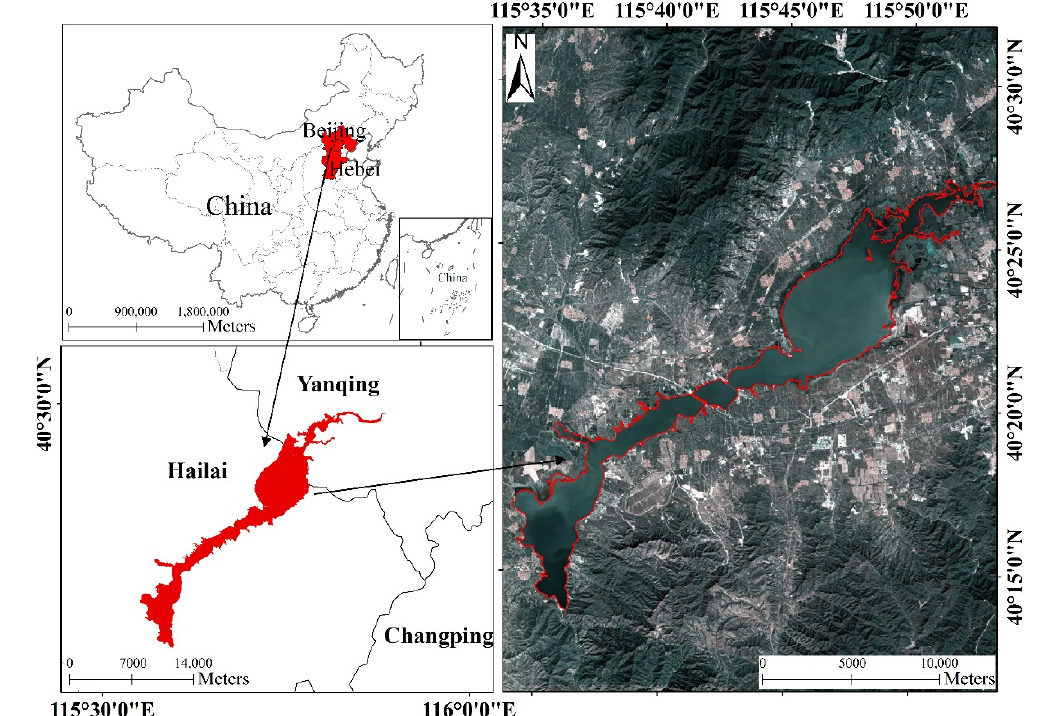
Figure 1. Study area in Guanting Reservoir. The location for Guanting Reservoir is in Huailai County, Zhangjiakou City, Hebei Province, China, and Yanqing County, Beijing City, China. Remote sensing image (30 × 30 m/pixel) is the combination of the band 4, band 3, and band 2 of Landsat-8 in September 2019.